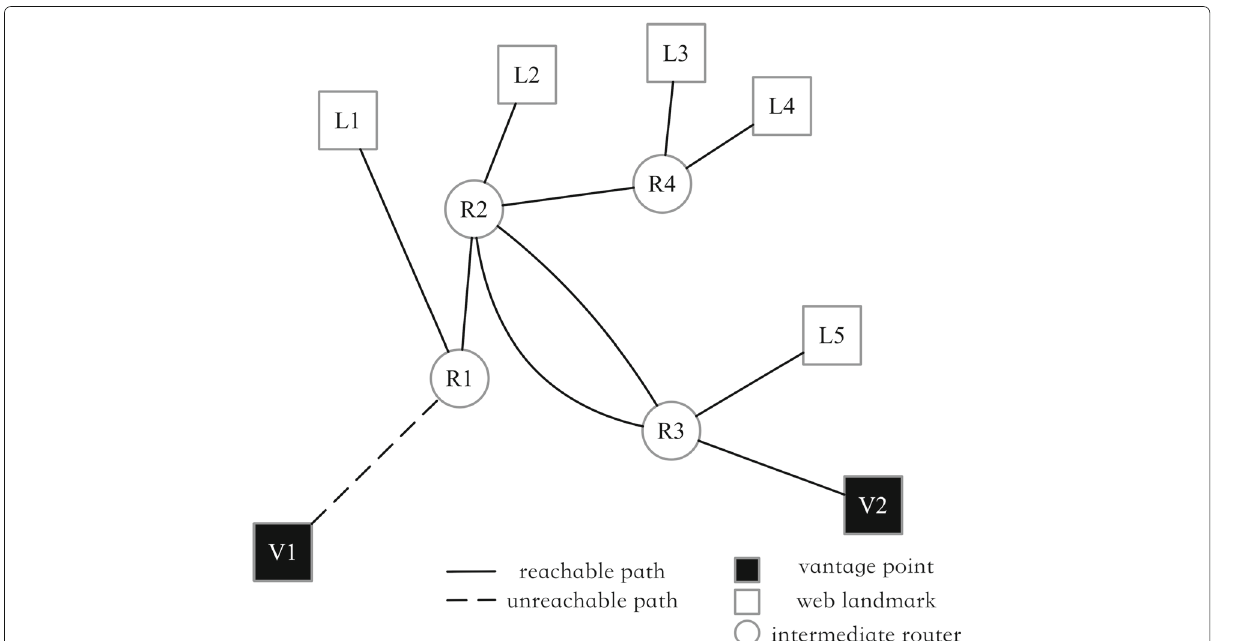
Fig. 2 Controlling vantage points to discover intermediate routers